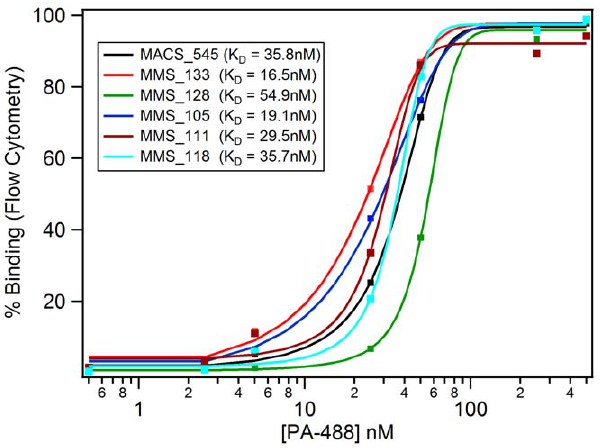
Figure 7. Affinity Analysis of Single Clones. Flow cytometry affinity analysis of the highest affinity clones for MMS and the best MACS/FACS clone. The cells were analyzed for affinity using 500, 250, 50, 25, 5, 2.5, 0.5, and 0 nM of the PA-Dylight 488 sample. The dissociation constant (K D ) is shown for each sample. doi:10.1371/journal.pone.0026925.g007 PLoS ONE |